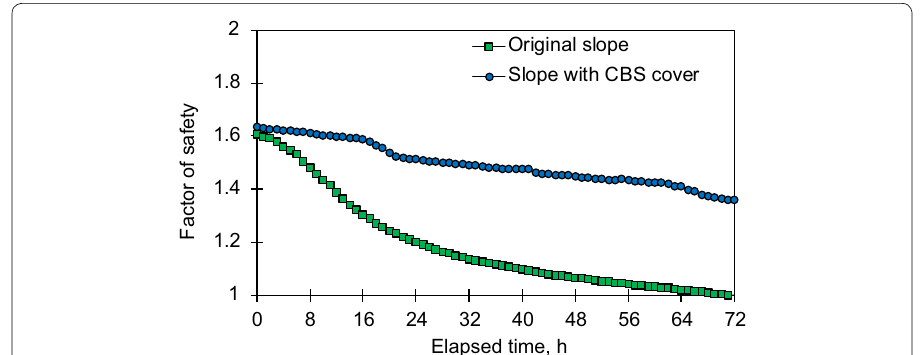
Fig. 15 Variations in factor of safety for the original slope and the slope with CBS cover